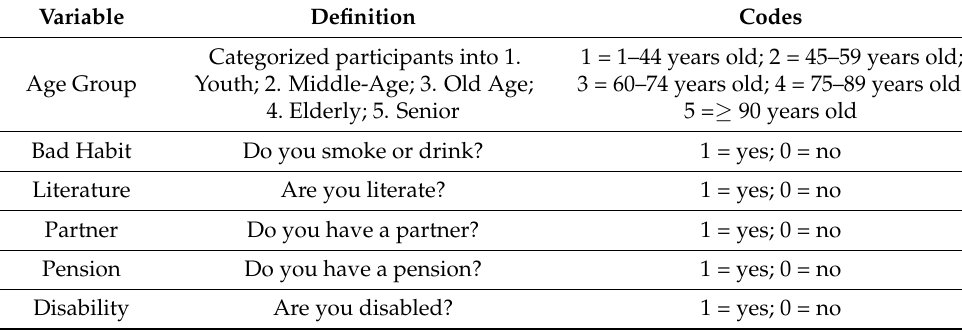
Table 8. Added control variables for the robustness test.